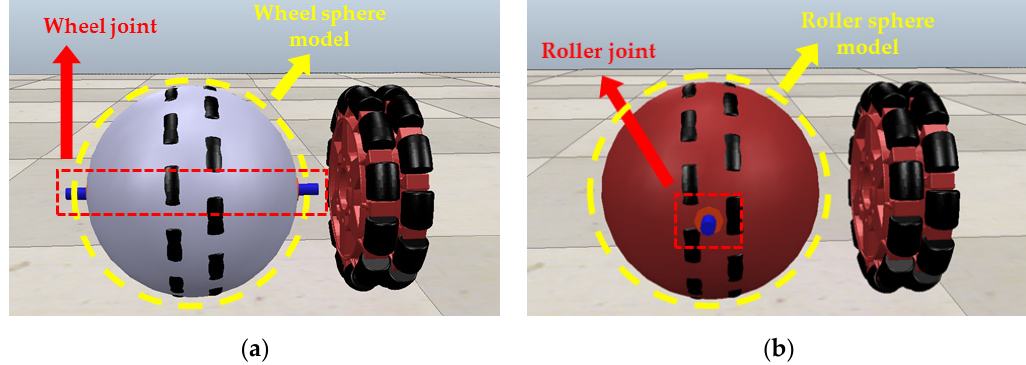
Figure 5. Modelling of ( a ) wheel and ( b ) roller of the big omniwheel by using joint and sphere respectively in V-REP.